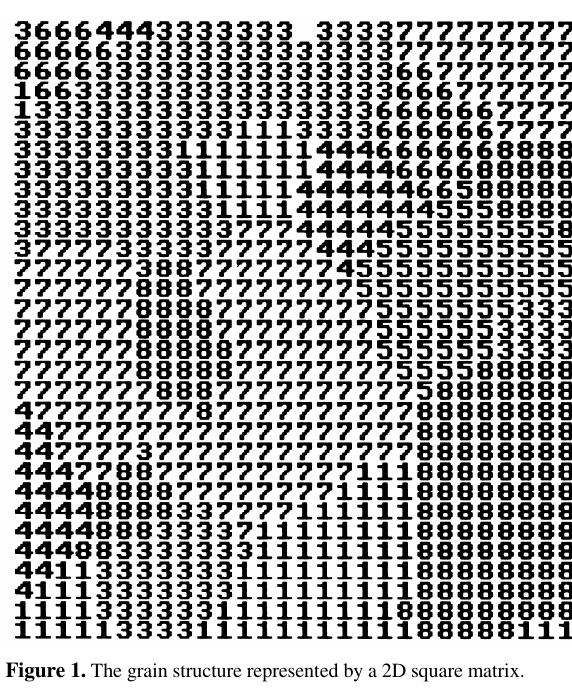
Figure 1. The grain structure represented by a 2D square matrix.